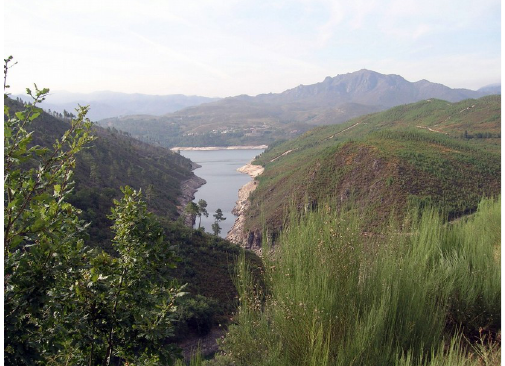
Figure 2. Landscape of Serra Xures natural